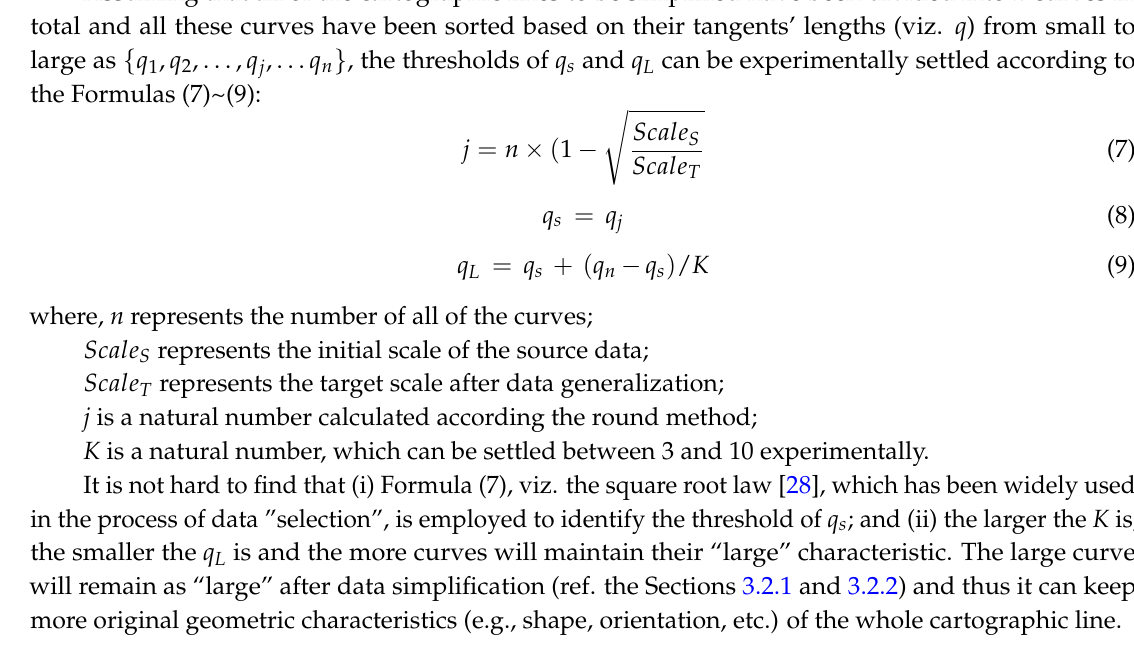
Table 2. Criteria values of ( q_ small , q_ large ) to determine the sizes of curves. Size Large Curve Small Curve Minimum Curve Parameters q > q L ( q S , q L ) < q